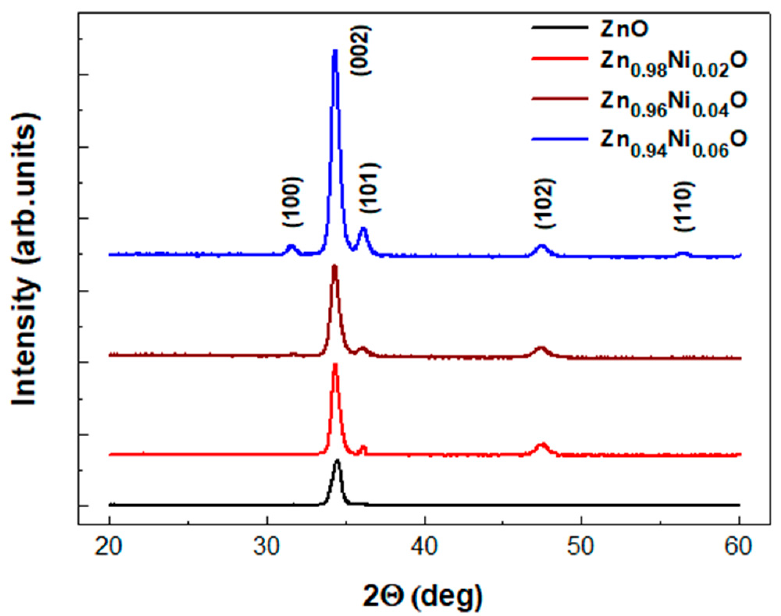
Figure 1. X-ray diffraction spectra of Zn 1 − x Ni x O films with different Ni contents (x). The calculation results indicate a decrease in the crystallite size with an increase in the nickel concentration. The same behaviour was observed for ZnO:Ni [26] and ZnO:Al [27] thin films. Obviously, the introduction of Ni atoms into the ZnO structure and an increase in their concentration determines the preferential location of the dopant atoms in the regions of grain boundaries or near them, which determines the decrease in the crystallite size. The lattice constants a and c for the samples of Zn 1 − x Ni x O films were calculated using the Formula (2) and (3) [28] and depicted in Figure 2: